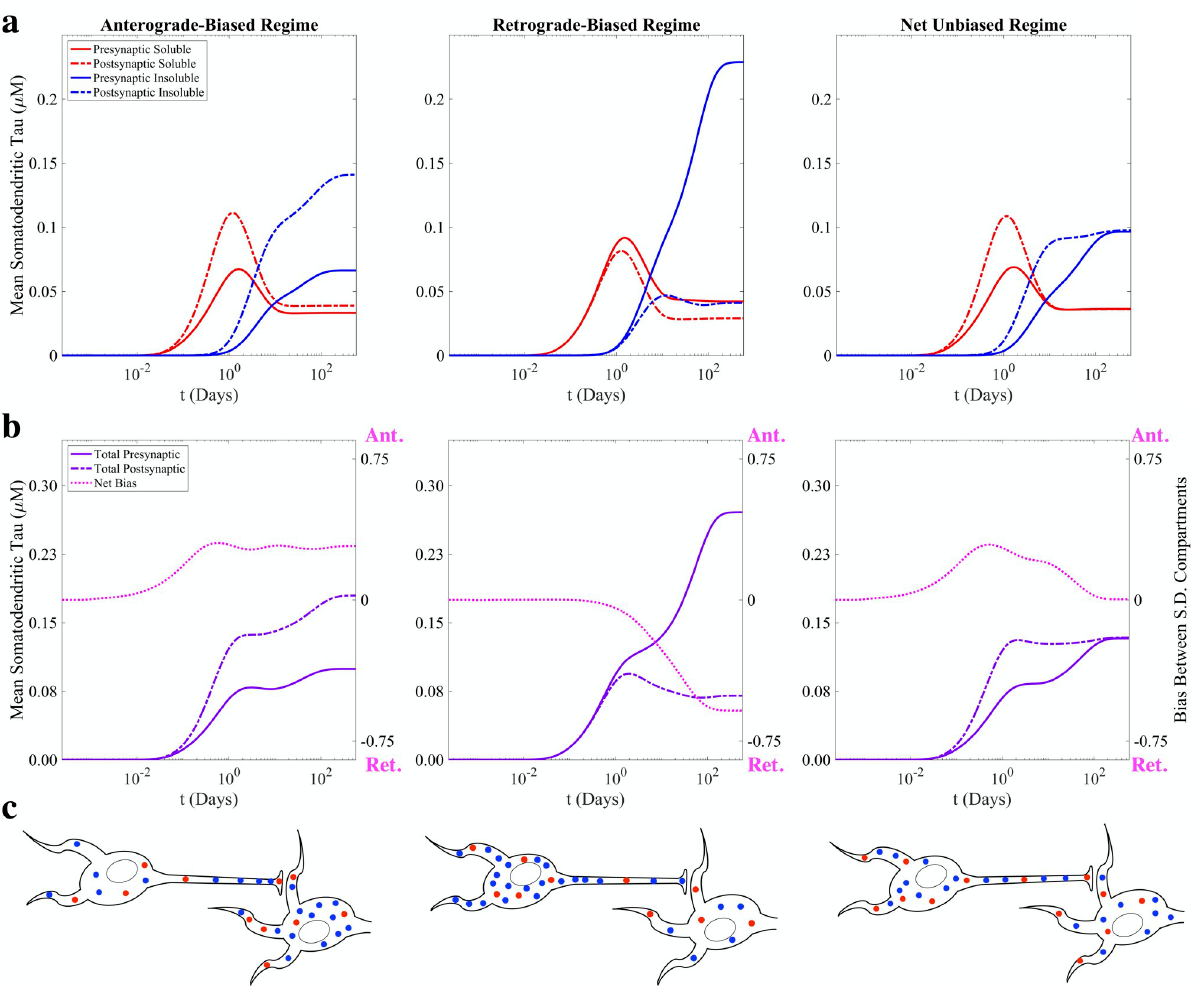
Fig 3. Temporal profiles of somatodendritic tau deposition. (a) Time course of mean soluble (red) and insoluble (blue) tau deposition in the presynaptic (solid lines) and postsynaptic (dashed lines) SD compartments for each of the previous simulation conditions. (b) Total presynaptic (purple solid line) and postsynaptic (purple dashed line) tau can be used to calculate a net bias at each time point (magenta dotted line; Eq 15). The balance between transport parameters δ and � determines the compartment in which tau preferentially accumulates and if there is a net bias over time. (c) Schematized versions of the end configurations of the system for each parameter